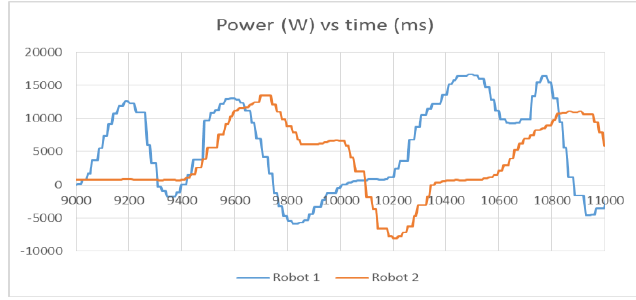
Fig. 12. Instant power consumption of two simultaneously working robots acquired through